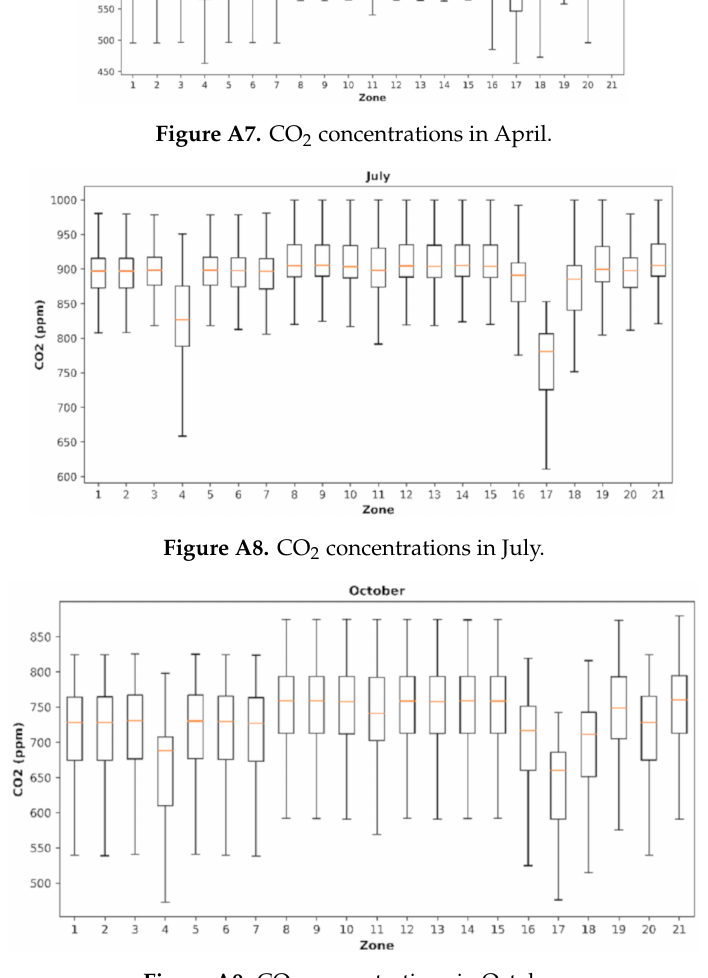
Figure A9. CO 2 concentrations in